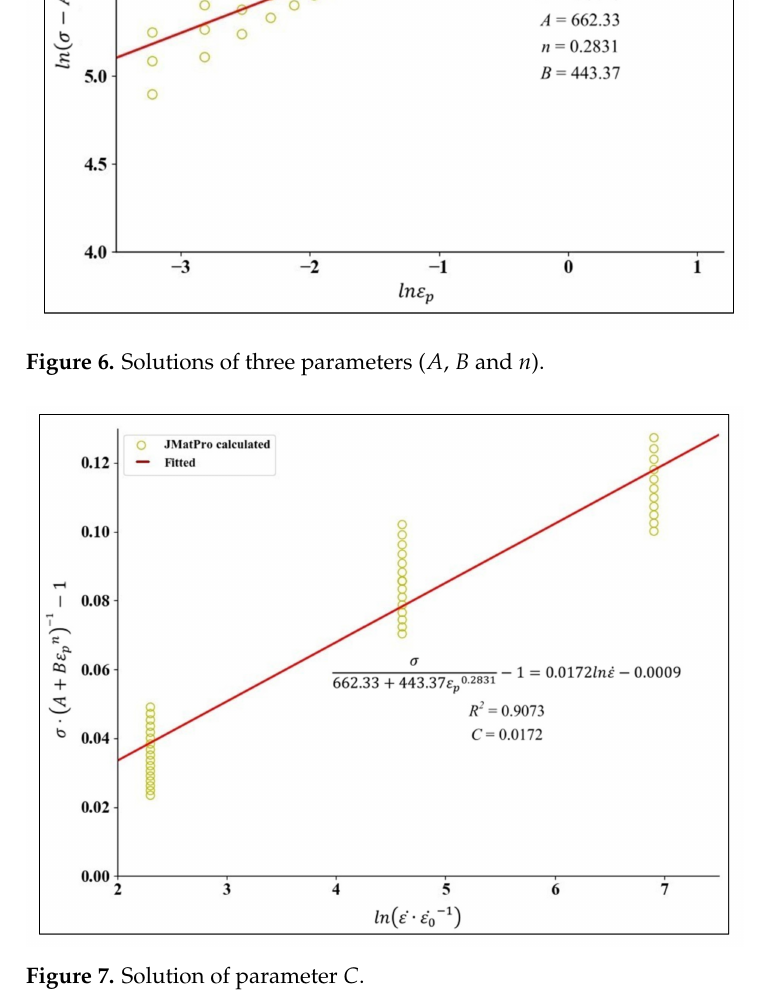
Figure 7. Solution of parameter C